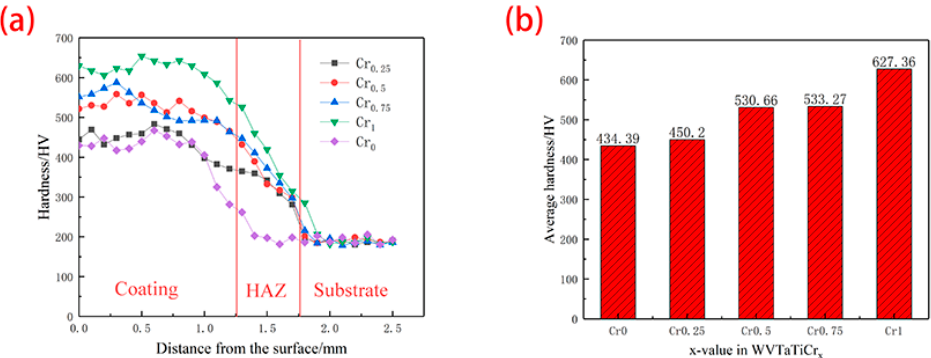
Figure 5. Hardness of WVTaTiCr x RHEA coating: ( a ) cross-section hardness; ( b ) average hardness of coating area.